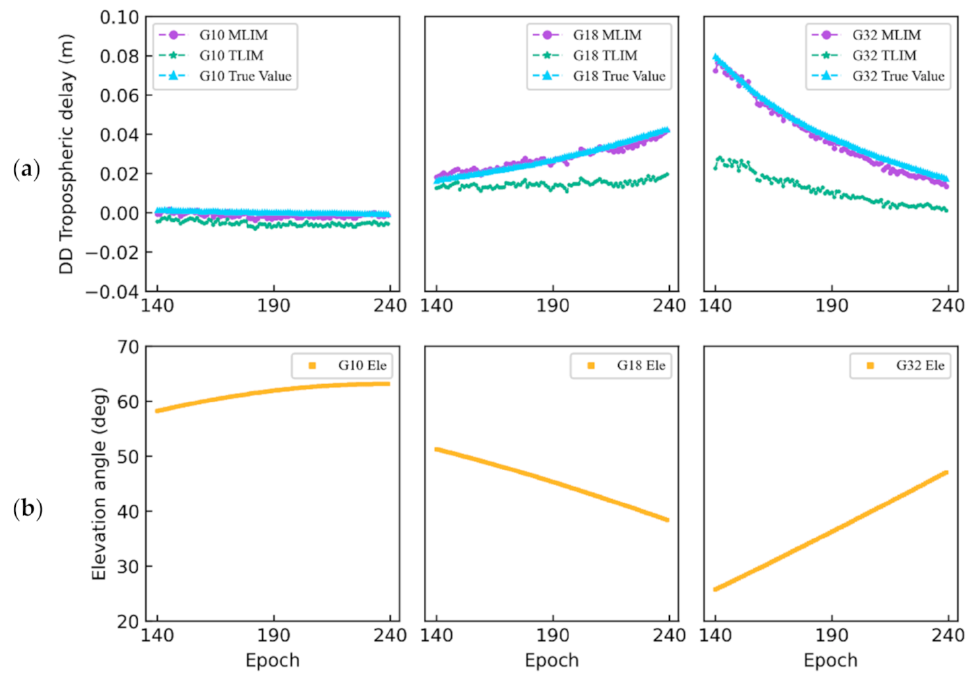
Figure 5. The DD tropospheric delay obtained by different methods ( a ) and elevation angles ( b ) for satellites G10, G18, and G32 at the rover station